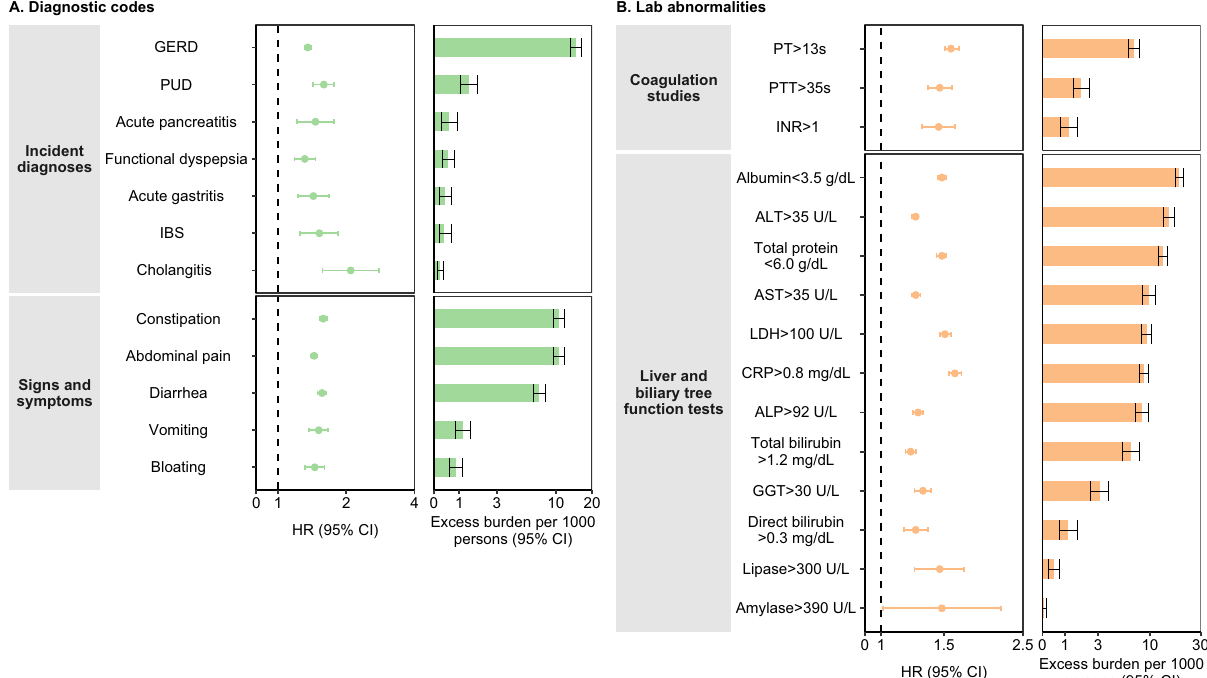
Fig. 1 | Risks and 1-year burdens of incident post-acute COVID-19 gastro- intestinal outcomes compared with the contemporary control cohort. Out- comeswereascertained30daftertheCOVID-19-positivetestuntiltheendoffollow- up. COVID-19 cohort ( n = 154,068) and contemporary control cohort ( n = 5,638,795).Panel A describestherisksandburdensofincidentdiagnoses(light green) and panel B describes the risks and burdens of incident laboratory abnormalities(orange).AdjustedHRs(dots)and95%(errorbars)CIsarepresented, as are estimated excess burdens (bars) and 95% CIs (error bars). Burdens are